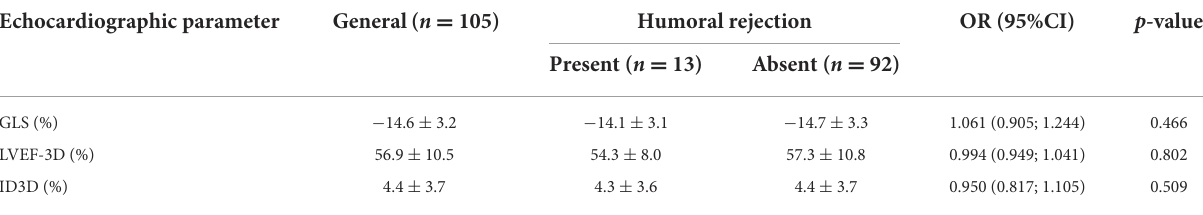
TABLE 14 Strain and three-dimensional assessment of the left ventricle according to antibody-mediated (humoral) rejection identified by immunofluorescence or immunohistochemistry. Echocardiographic